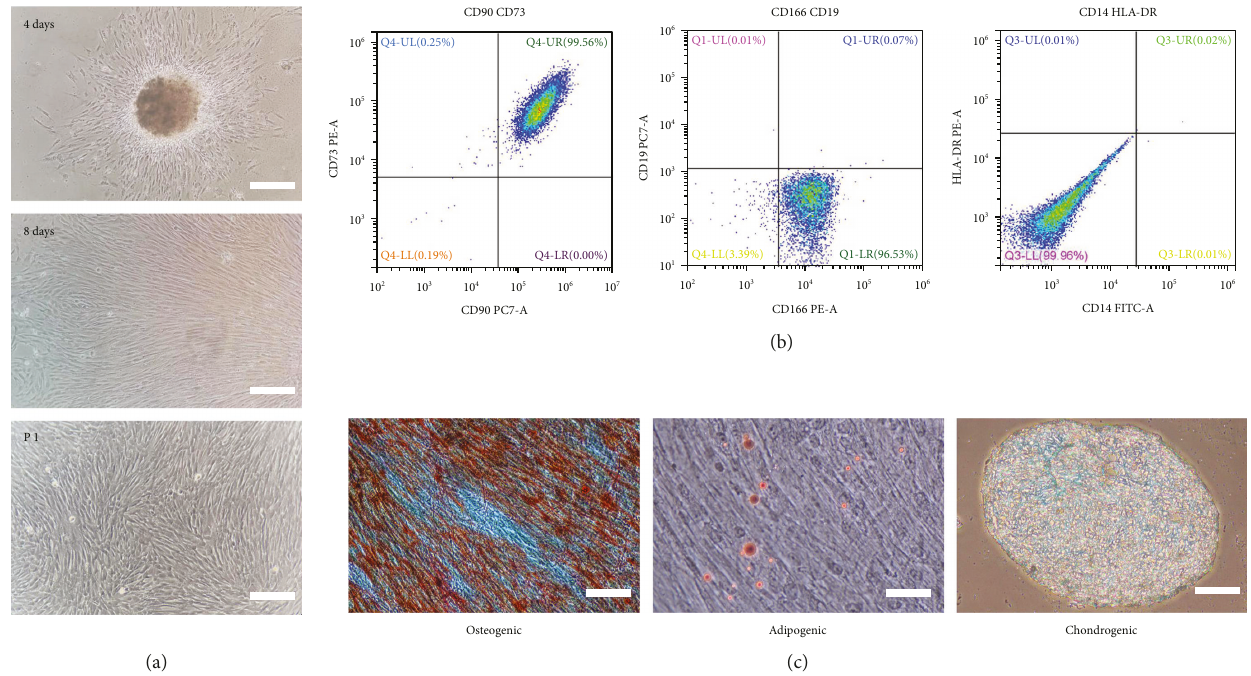
Figure 3: Isolation, culture, and identi fi cation of DPSCs. (a) DPSCs culture at day 4, day 8, and the fi rst passage. Scale bar: 200 μ m. (b) The expression of surface markers of DPSCs. (c) The osteogenic/adipogenic/chondrogenic di ff erentiation potential of DPSCs. Scale bar: 100 μ m.